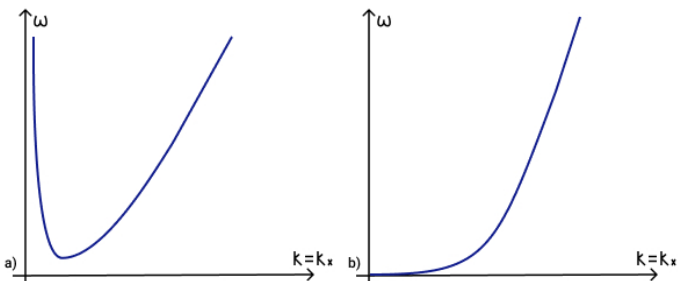
Figure 22. Dispersion curves for magneto-Rossby waves in ( a ) external vertical magnetic field and in ( b ) horizontal magnetic